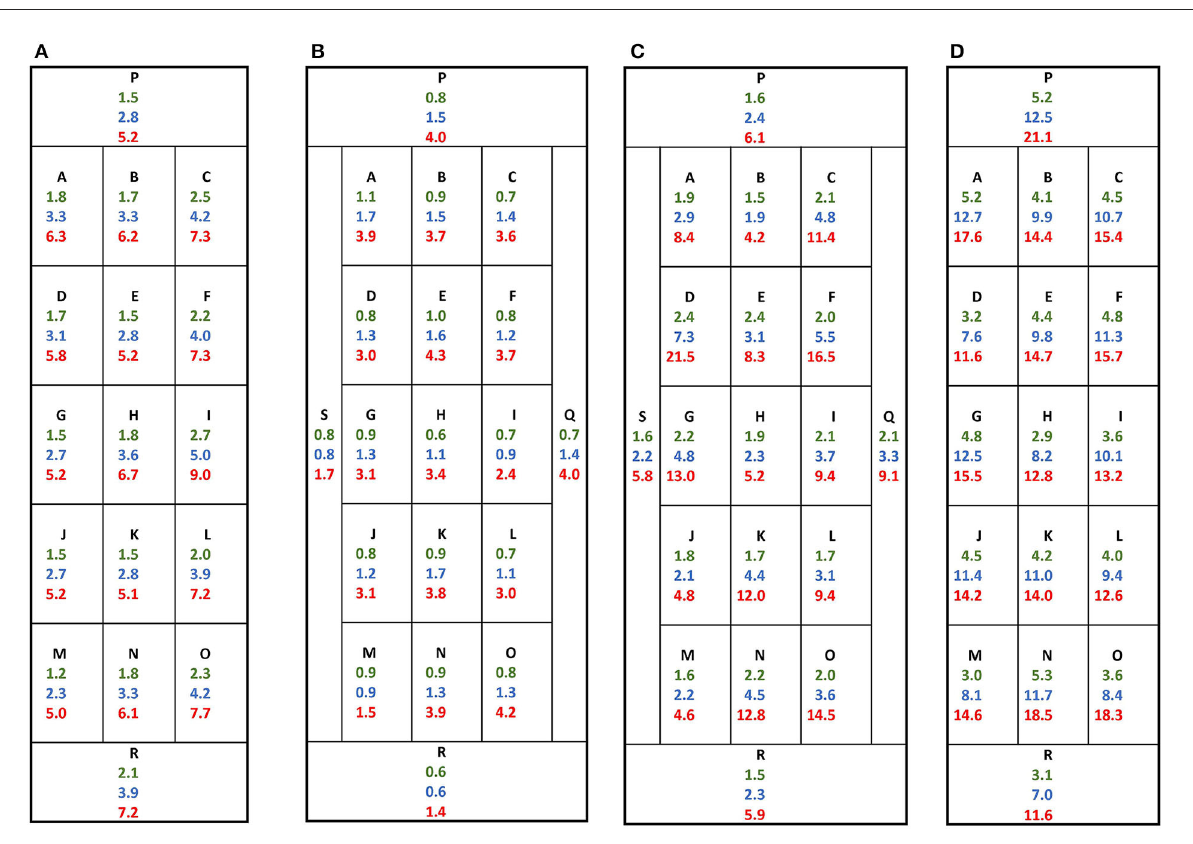
FIGURE2 Intrinsic background dose distribution over the surface of four screen potectors. The corresponding intrinsic background doses for an aliquot of each part are given in Gy for three integration ranges (in green: 100–150 ◦ C, in blue: 100–200 ◦ C and in red: 100–250 ◦ C). Screen protector ID: